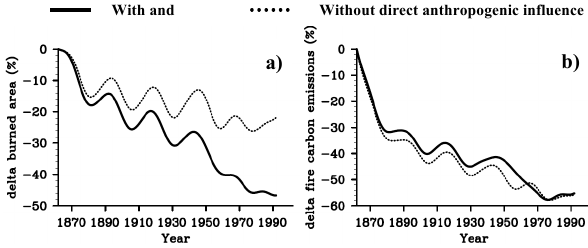
Fig. 18. Historical variation of (a) global burned area and (b) fire carbon emissions in simulations with and without direct anthro- pogenic influence. 25yr low-pass filter is